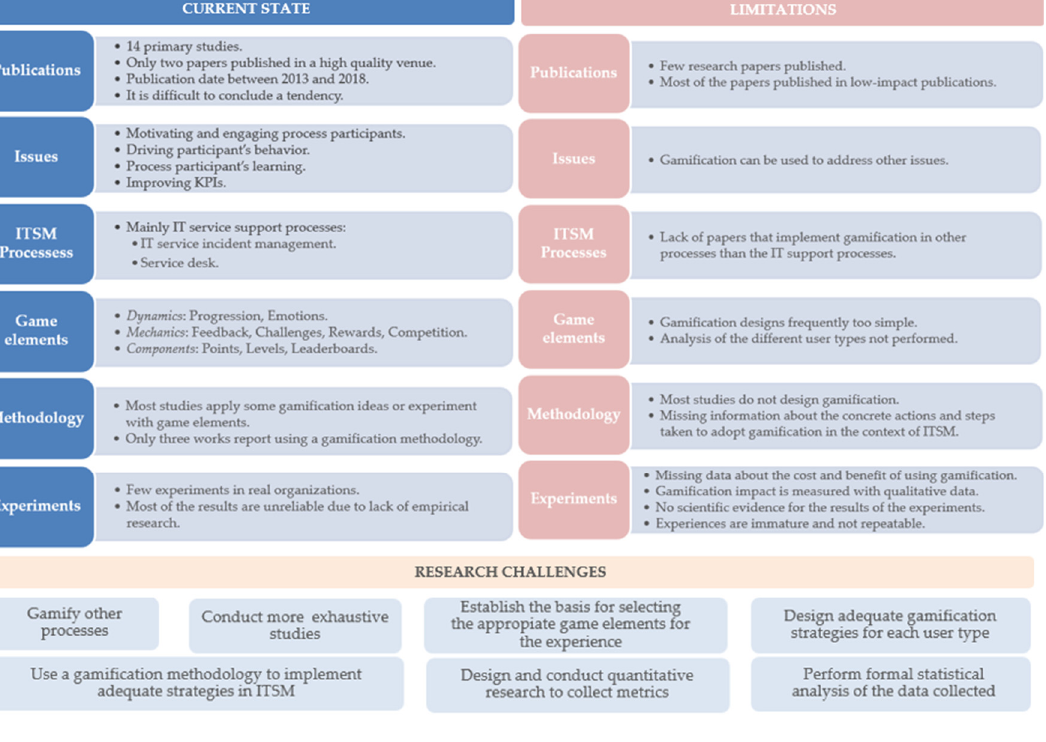
Figure 9. Current state, limitations and research challenges of gamification in ITSM.